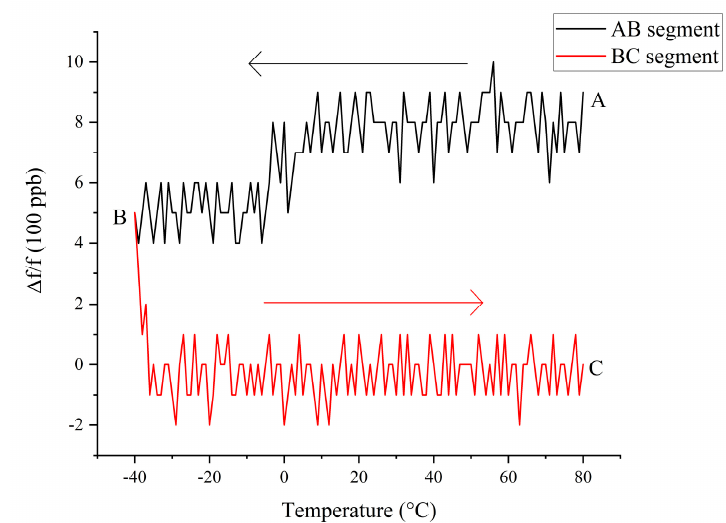
Figure 8. Hysteresis test diagram of compensation point measurement during the temperature rise process.